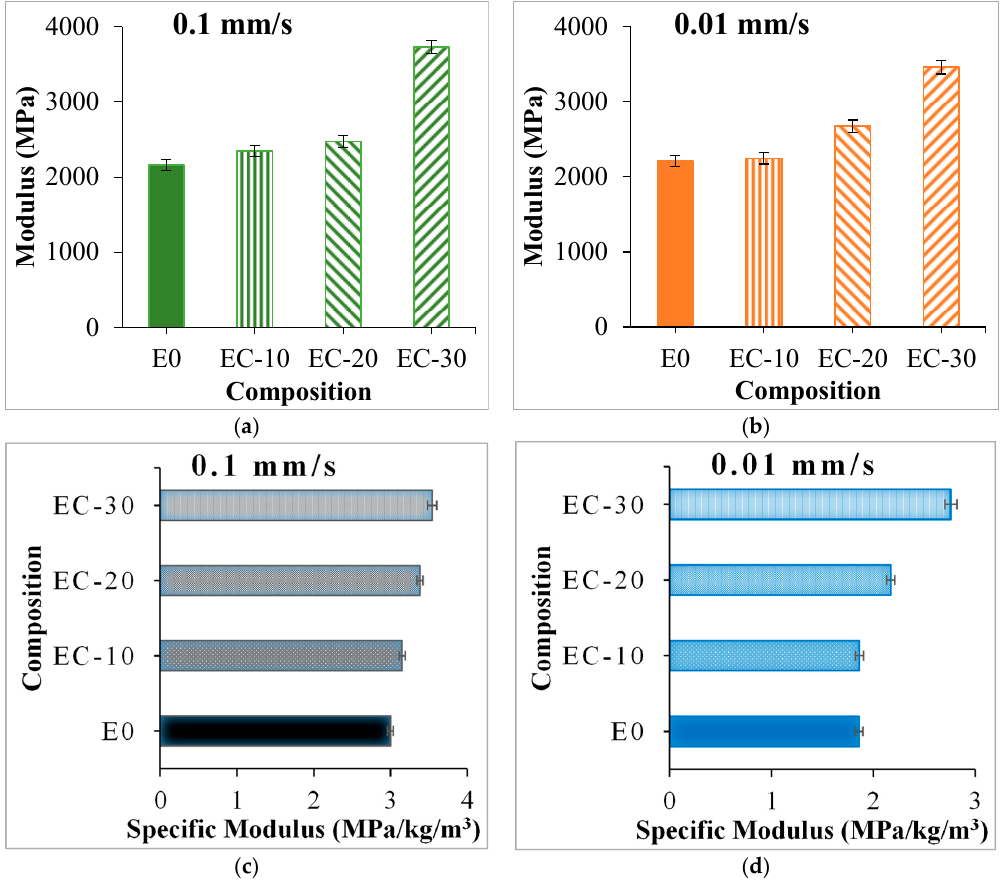
Figure 6. Experimentally measured flexural modulus at ( a ) 0.1 mm/s and ( b ) 0.01 mm/s, and specific flexural modulus at ( c ) 0.1 mm/s and ( d ) 0.01 mm/s.